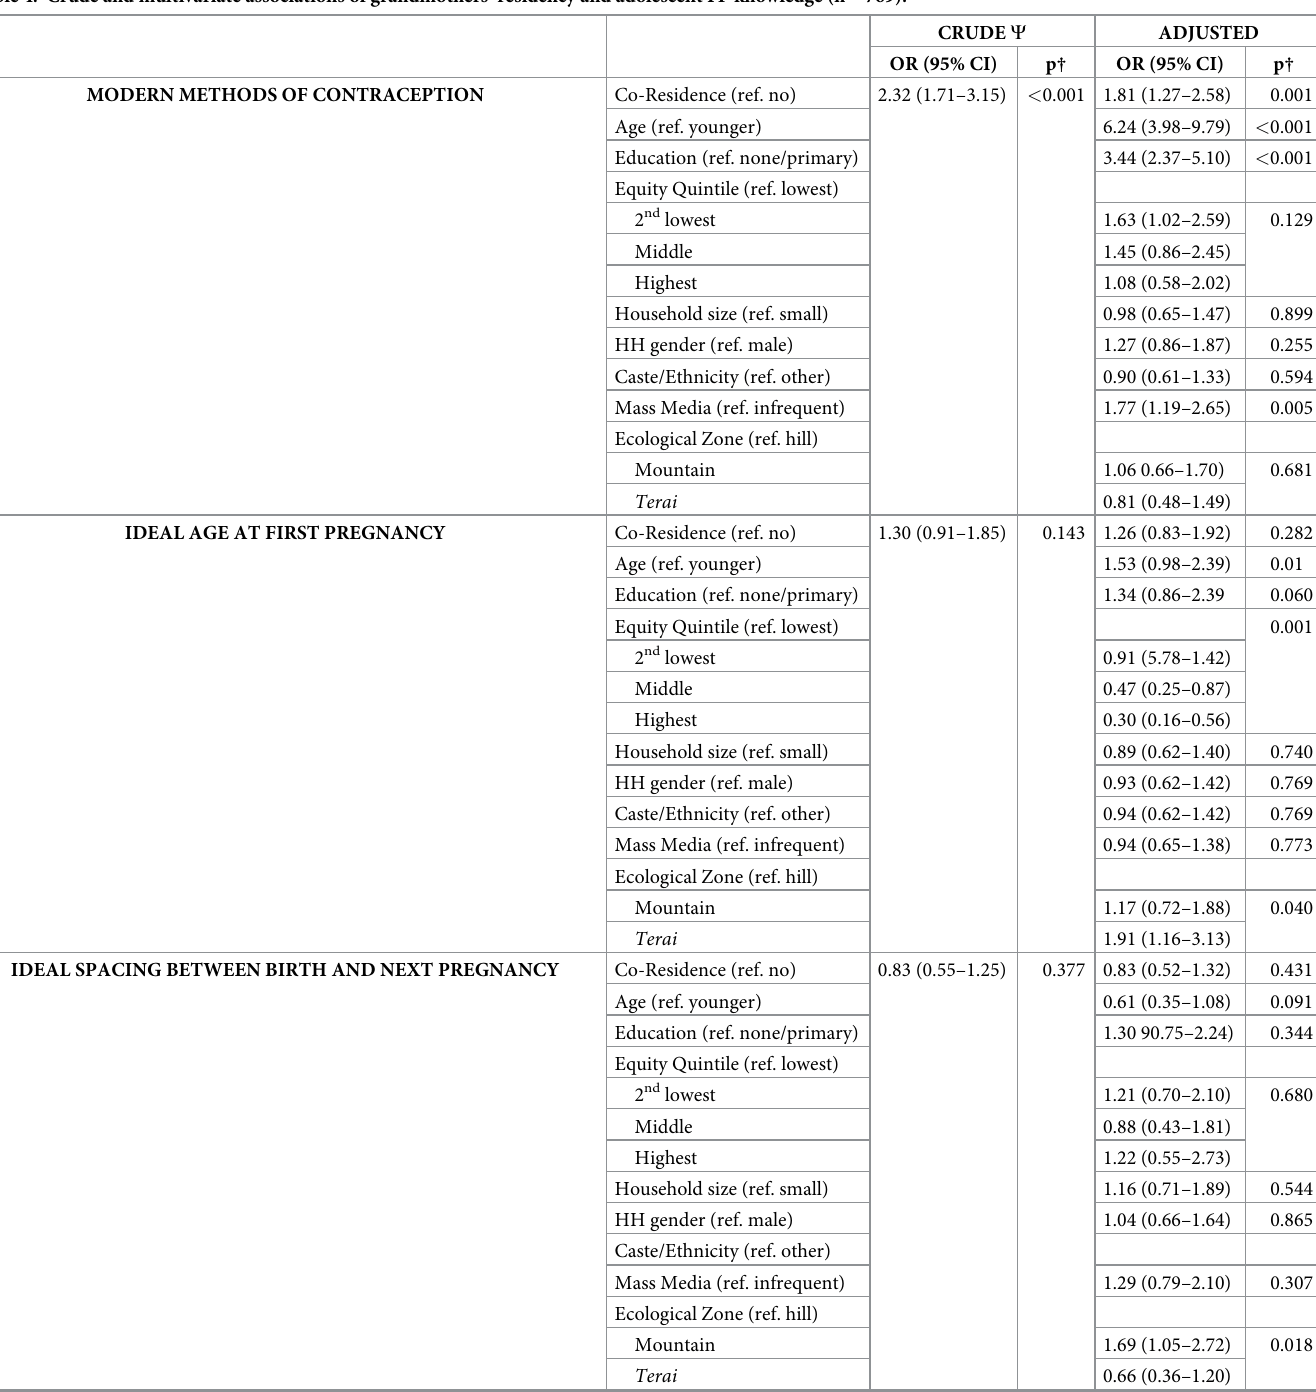
Table 4. Crude and multivariate associations of grandmothers’ residency and adolescent FP knowledge (n =